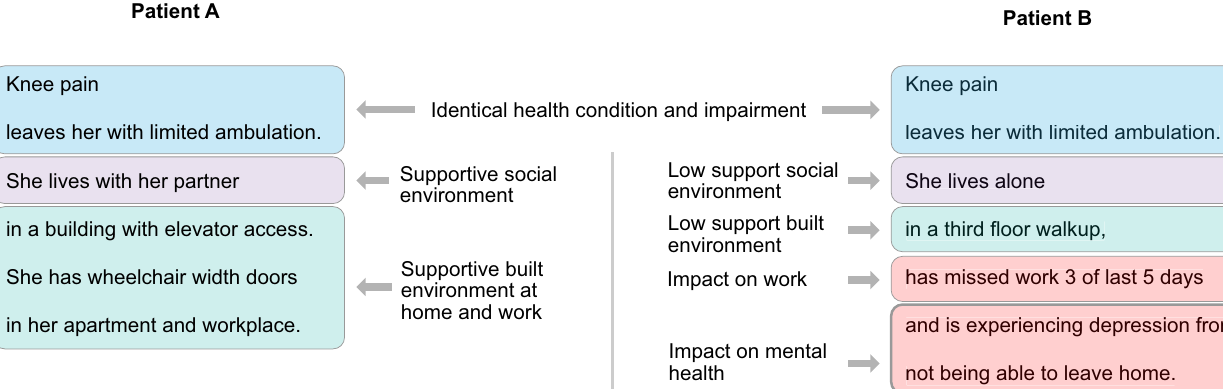
Fig 4. Example of differences in environmental factors for patients with identical health conditions and impairments. Both patients would score the same on unassisted walk tests, but the additional information provided distinguishes between a patient with access to facilitators in relevant environments (Patient A) and one facing significant environmental barriers (Patient B). The text highlighting indicates conceptual organization of information only; however, a similar analysis could be conducted automatically with NLP techniques. NLP, natural language